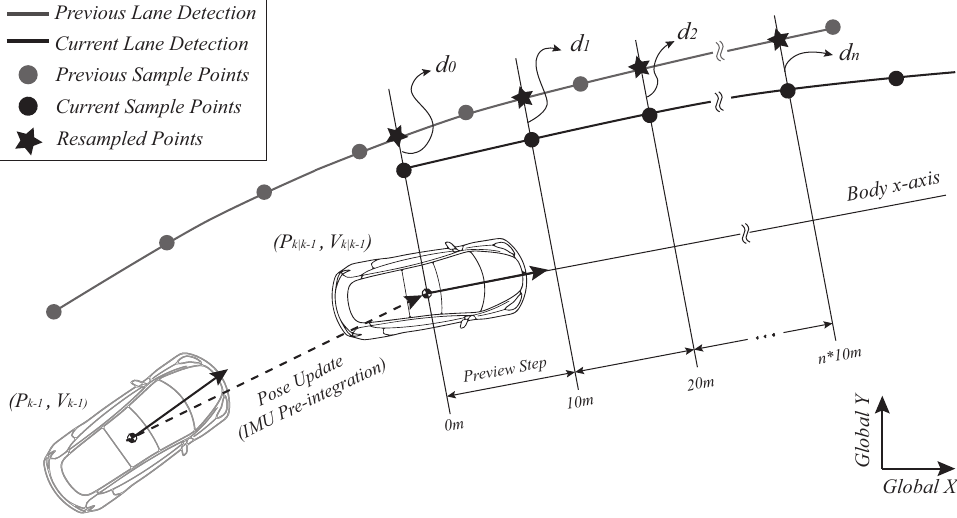
Figure 4. Observer Model: Predicting lateral distance to the previewed